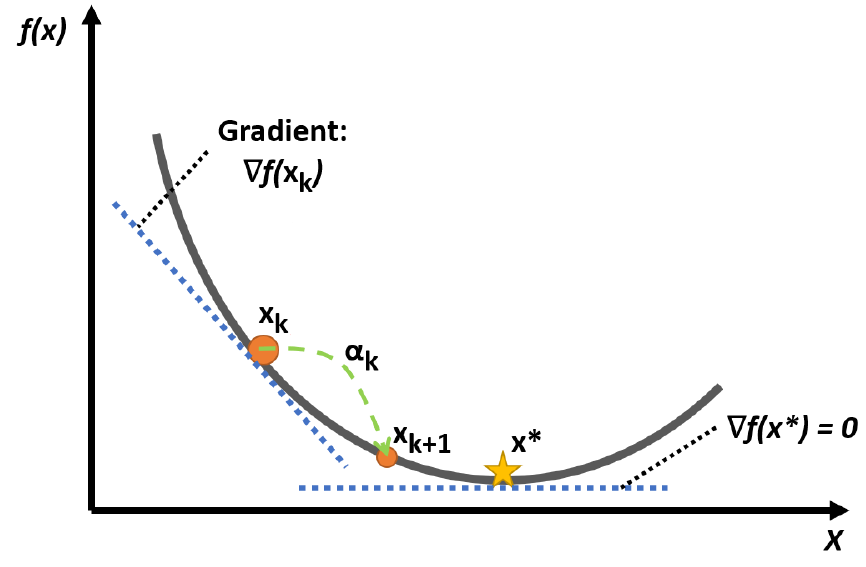
Figure 2. The dot at x k on a convex f moves towards the next iteration x k + 1 with a step size α k . The descent direction is given by the gradient ∇ f ( x k ) , which is equal to zero when ∇ f ( x ∗ )